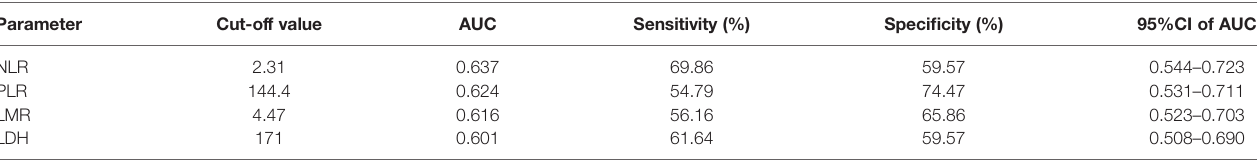
TABLE 2 | The cut-off value and area under the curve of the serum in fl ammatory biomarkers. Parameter